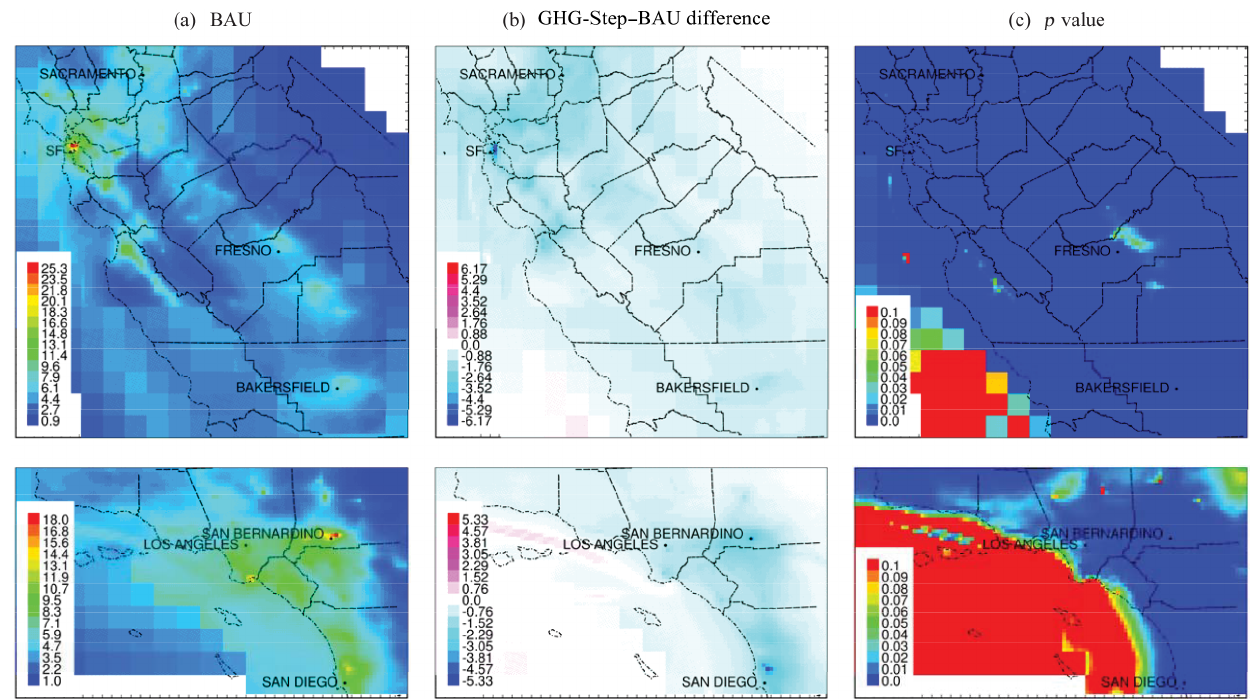
Figure 5. (a) Annual-average PM 2 . 5 mass concentration (µgm − 3 ) under the BAU scenario, (b) change in PM 2 . 5 mass concentrations (µgm − 3 ) under the GHG-Step scenario, and p -value significance level of the difference between concentrations predicted using the BAU and GHG-Step scenarios. All simulations for the year 2054. Both 24km resolution results and the finer 4km resolution results are shown, with the finer, smaller southern California or central-northern California domains overlaid upon the coarse California domain